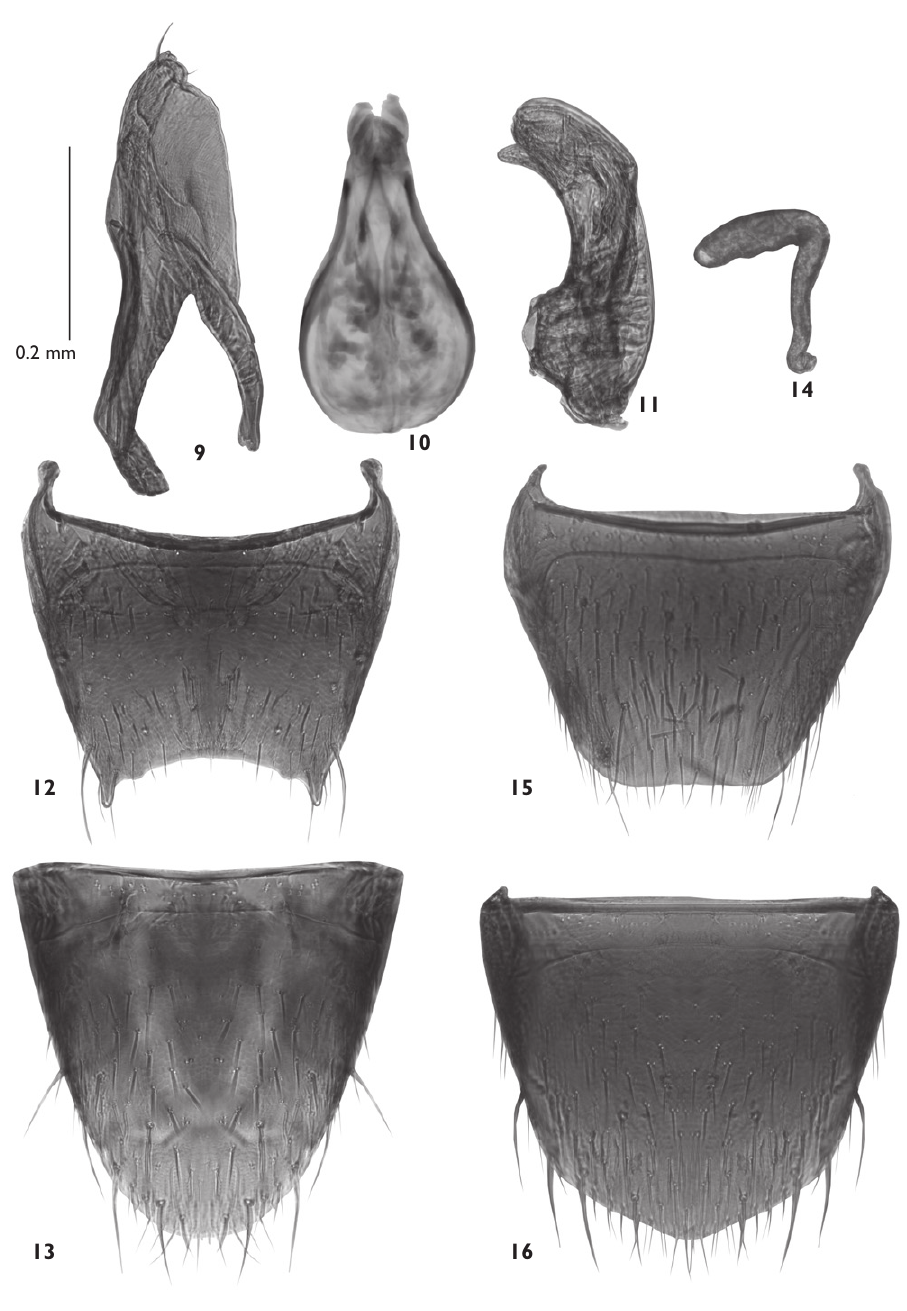
Figures 9–16 Schistoglossa charlottae : 9 paramere 10 median lobe of aedeagus in dorsal view 11